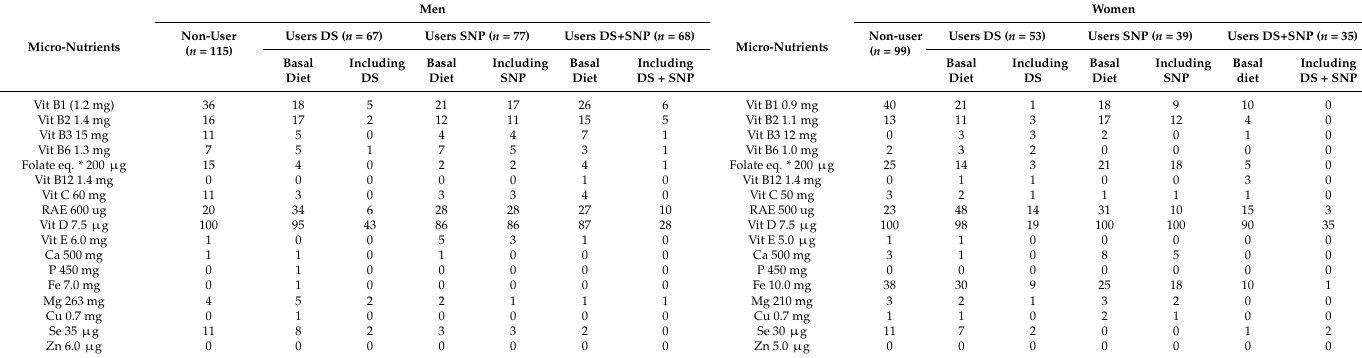
Table 4. Adequacy of micronutrient intake (%) in men and women presented for users and non-users of nutritional supplements.